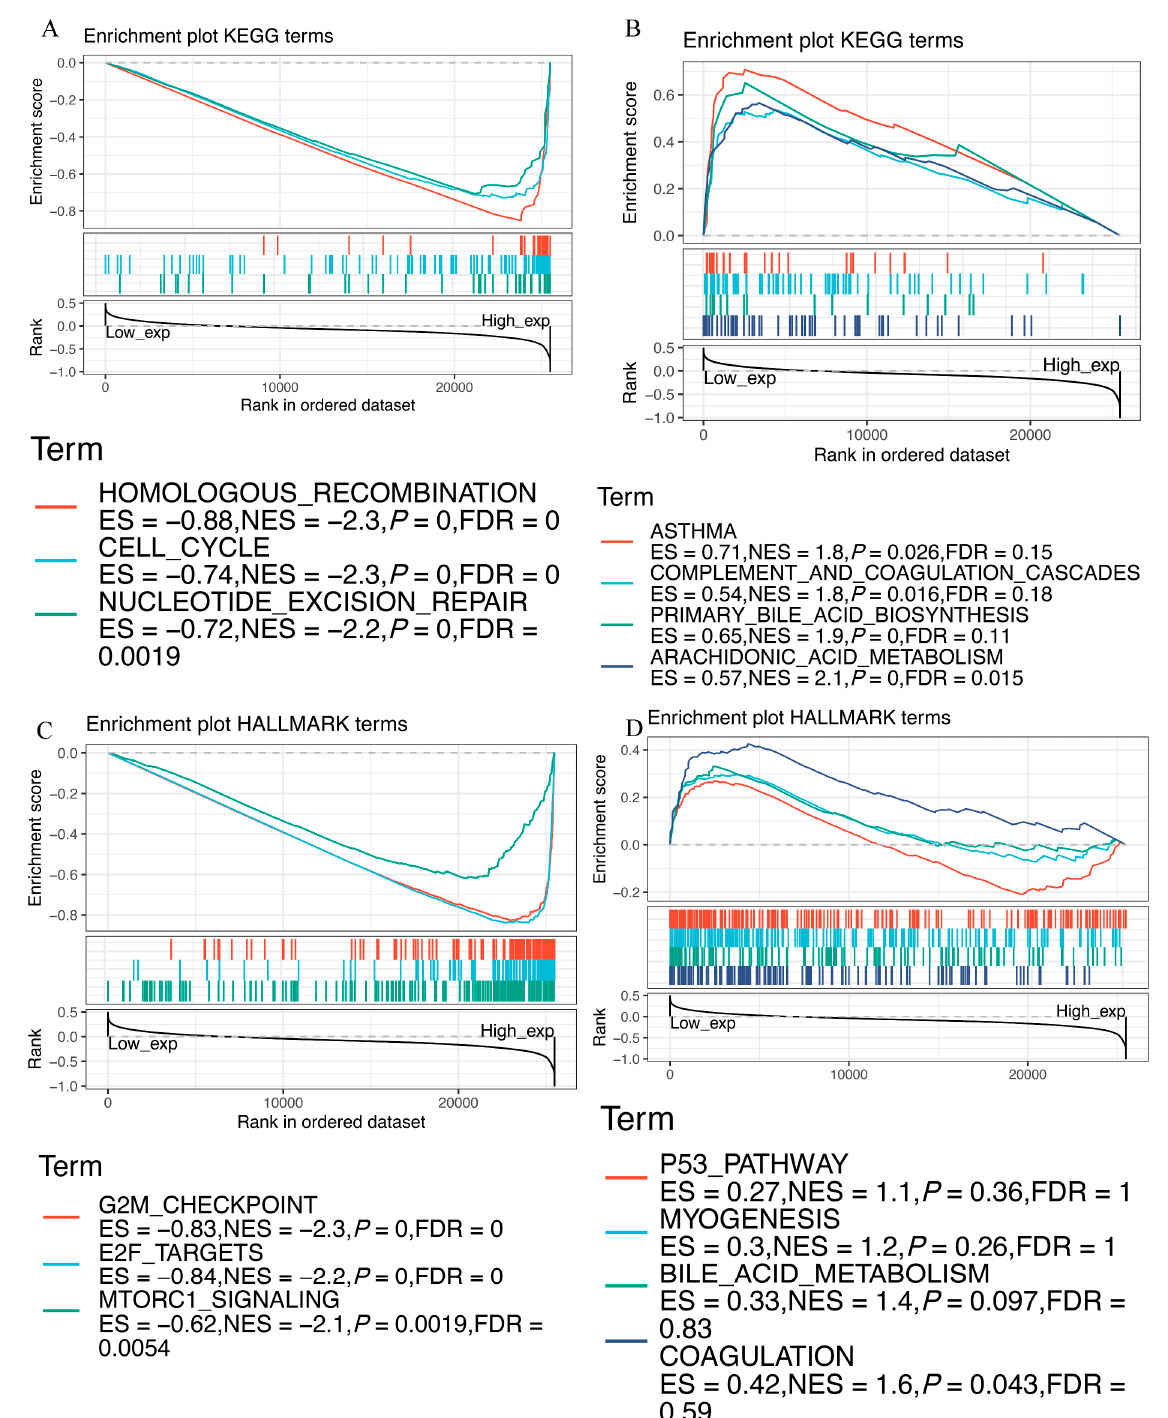
Figure 10. GSEA for samples with high and low EZH2 expression. ( A ) Enriched gene sets in the KEGG collection by samples with high EZH2 expression. ( B ) Enriched gene sets in KEGG by samples with low EZH2 expression. ( C ) Enriched gene sets in the HALLMARK collection by samples with high EZH2 expression. ( D ) Enriched gene sets in HALLMARK by samples with low EZH2 expression.